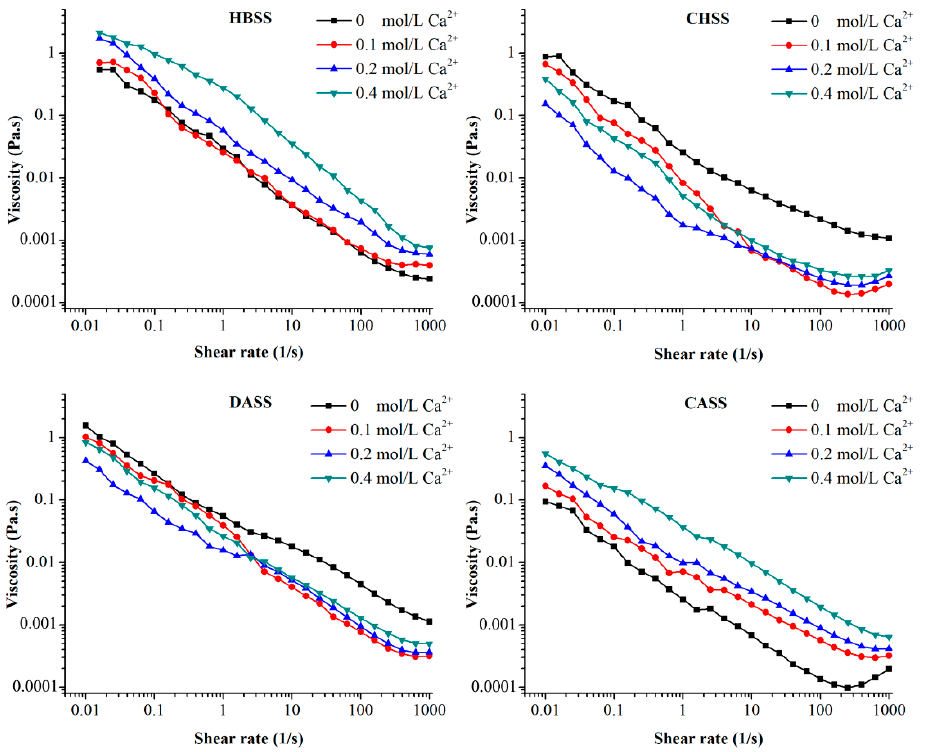
Figure 7. Variation of apparent viscosity of 1% MLPs with addition of different concentrations of CaCl2 at 20 °C.